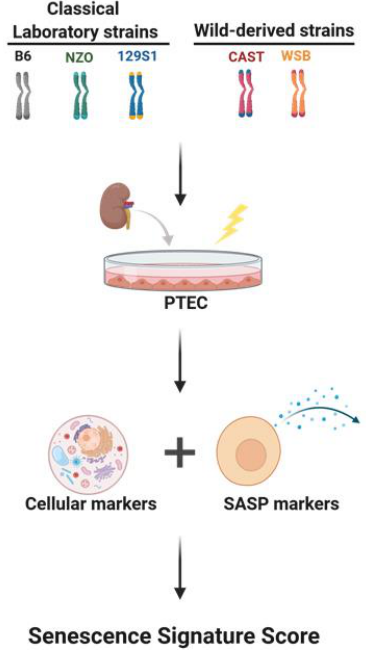
Figure 1. Schematic of experimental procedure and evaluation. Primary tubular epithelial cells (PTEC) generated from five laboratory strains C57BL/6J (B6), 129S1/SvImJ (129S1), NZO/HILtJ (NZO), WSB/EiJ (WSB), and CAST/EiJ (CAST), were irradiated and evaluated 3 and 10 days after irradiation for cellular senescence markers and for secretion of senescence associated secretory phenotype (SASP) markers. All markers were combined to build a senescence signature score for each strain.